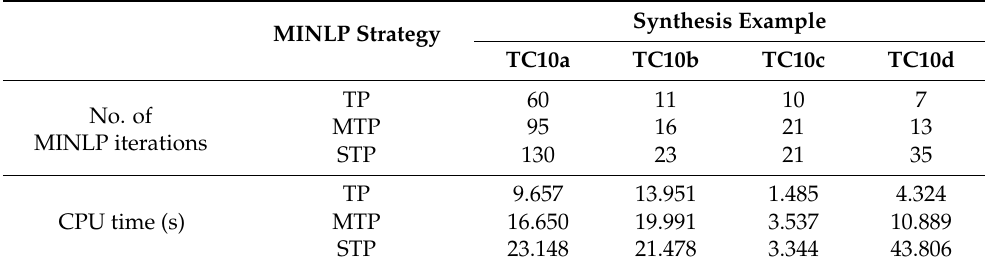
Table 5. Comparison of optimization statistics for different MINLP